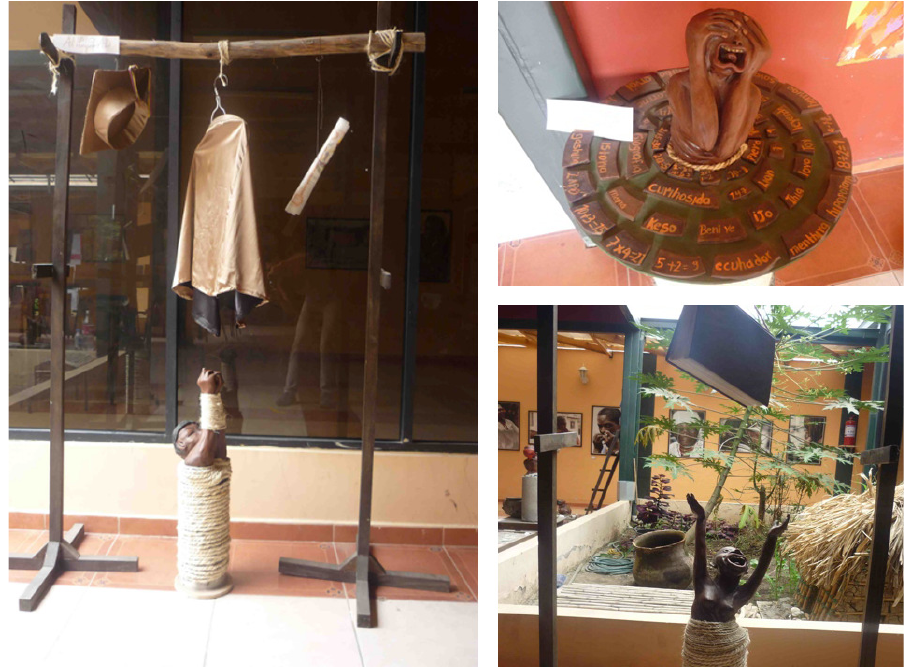
Figure 2. Artworks about the lack of access to a good quality education for most Afro‐Ecuadorians. Author of all the sculp‐ tures: Alicia Villalba. Photographs taken by María Gabriela López‐Yánez during an exhibition of the Afro‐Choteño artist, which took place in the Afro‐Choteño community of Juncal in